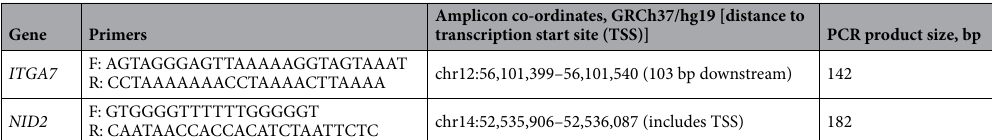
Table 5. Primers used to assess methylation of the ITGA7 and NID2 promoter regions by bisulfite Sanger sequencing.